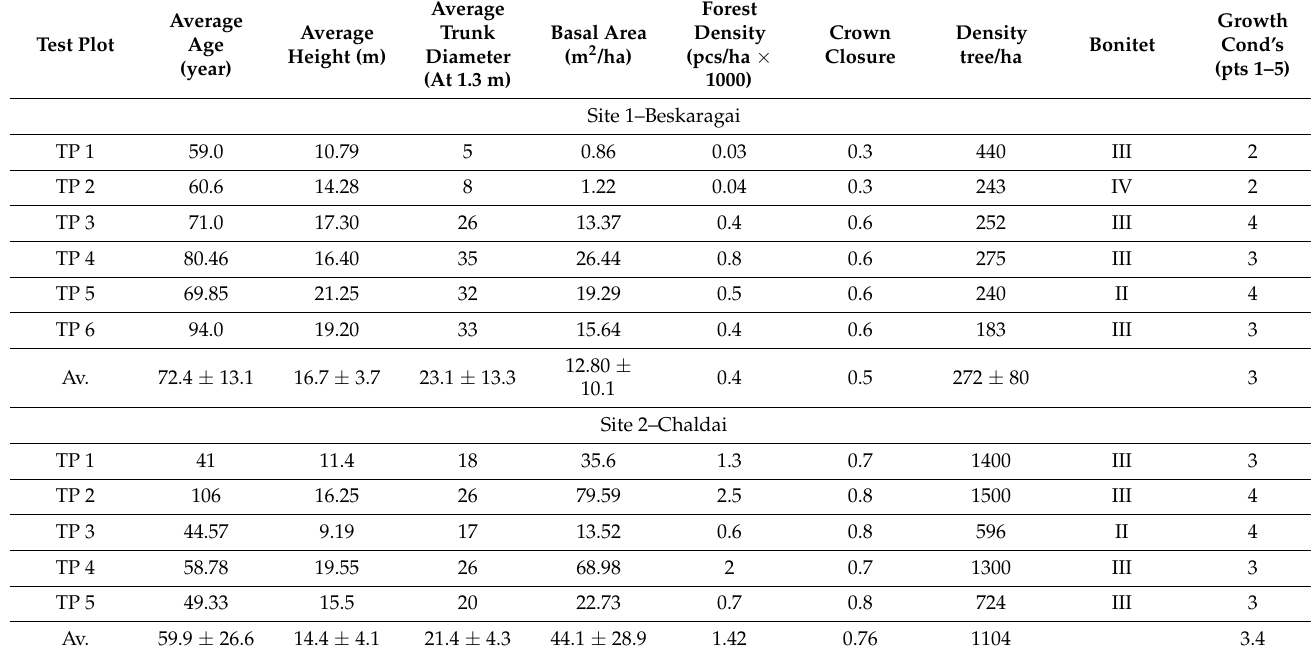
Table 2. Characteristics of pinetum of the Beskaragai and Chaldai Nature Reserves’ Forests.